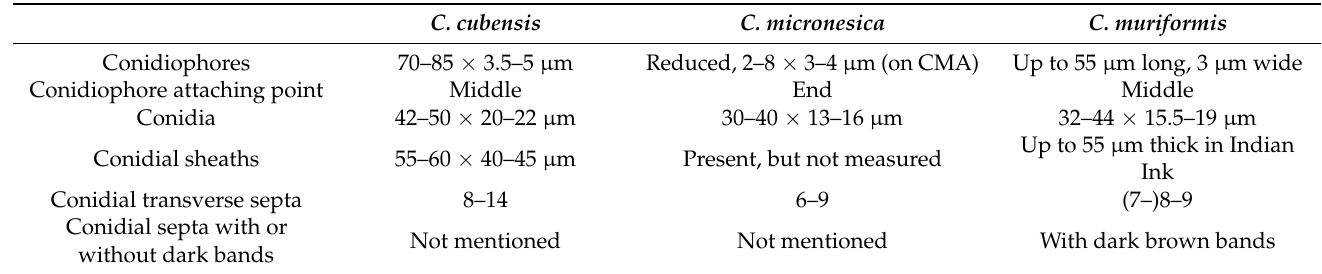
Table 2. Morphological comparison of Coleodictyospora species (on natural substrate) (update from Nakagiri and Ito